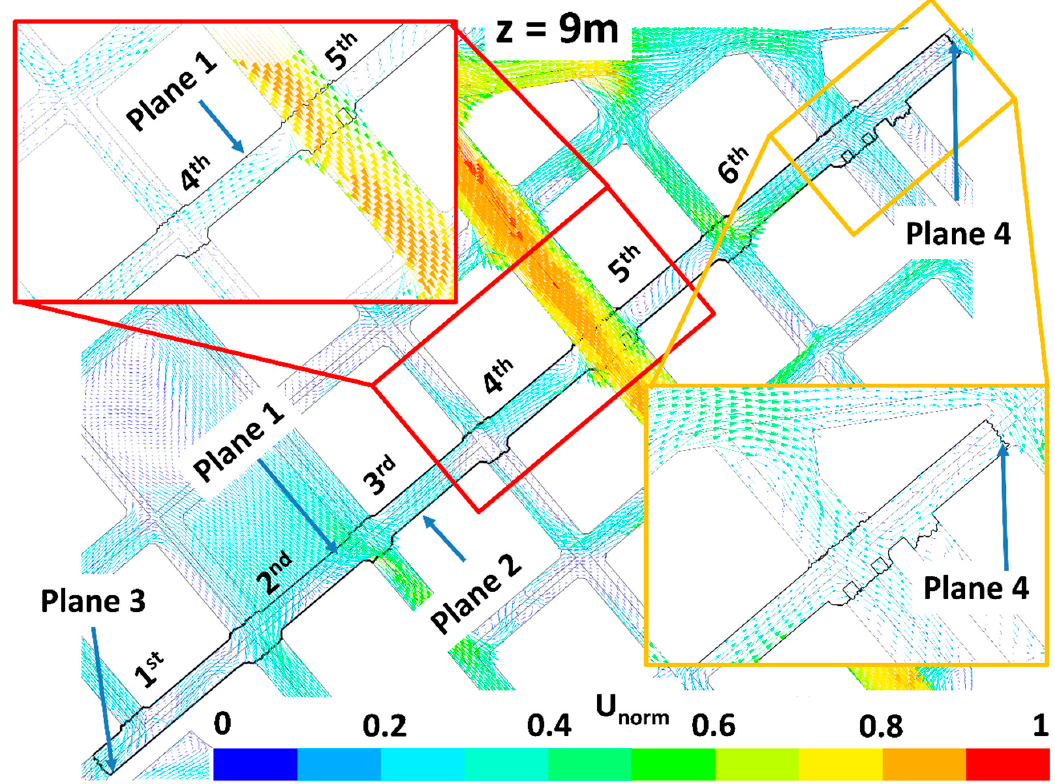
Figure 12. Same as Figure 10 but for the LAD01_NewTrees scenario.